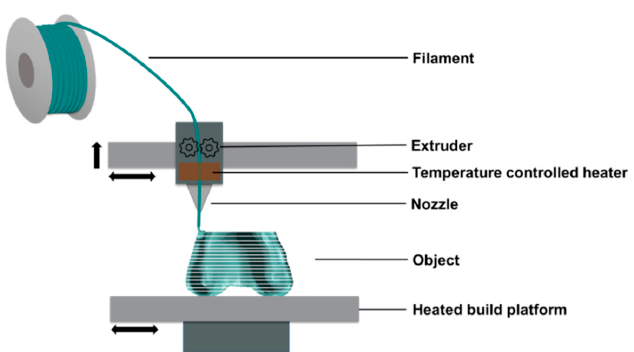
Figure 1. Fused filament fabrication (FFF), often referred to as fused deposition modeling (FDM), invented by Scott Crump at Stratasys Inc. (Eden Prairie, MN, USA), comprises a tempered extrusion printing head for deposition of molten thermoplastic material stored in feedstocks containing